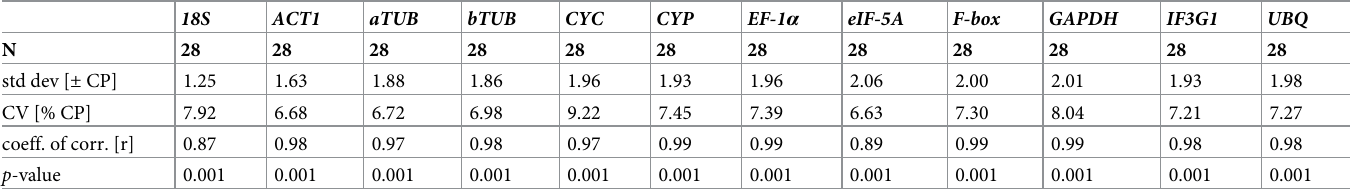
Table 3. The expression stability of the candidate reference genes determined by